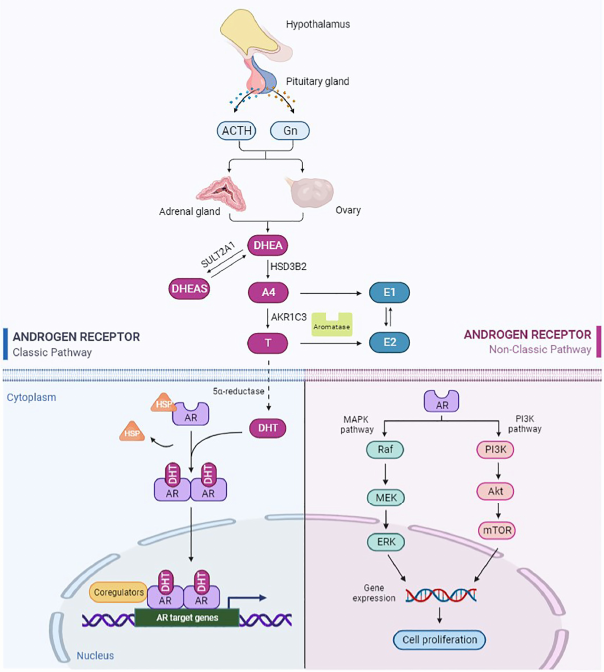
Figure 1. Schematic of androgen production, metabolism, and classical and nonclassical signaling pathways of AR. The figure was created with https://biorender.com (accessed on 1 September 2022).